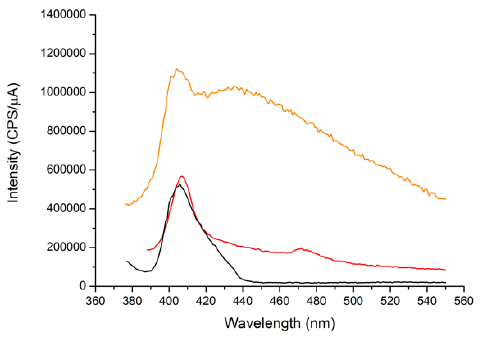
Figure 7. Emission spectra of RSNP (red line), SNP (orange line) and CSNP (black line) suspension in ethanol (250 mg/L) with a 362 nm excitation wavelength.